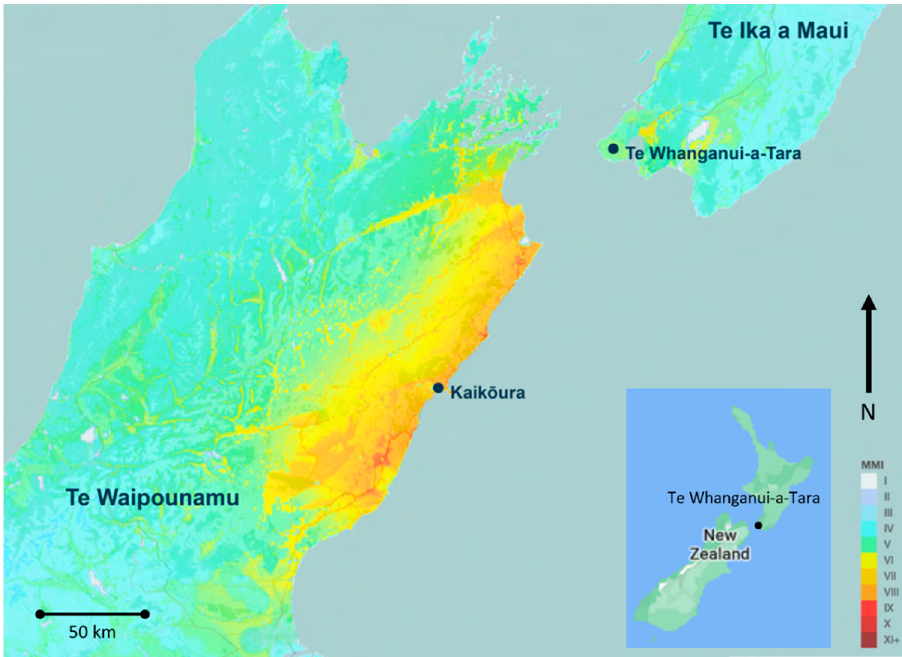
Figure 2. Location of the 2016 Kaik ō ura Earthquake in Aotearoa New Zealand by using ShakeMap data (Modified Mercalli Intensity (MMI) data) to show levels of shaking for different locations [28].